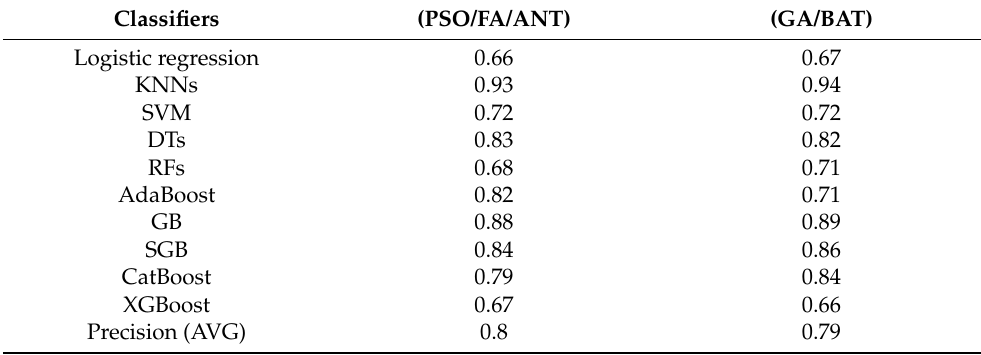
Table 6. Classifier performance using precision